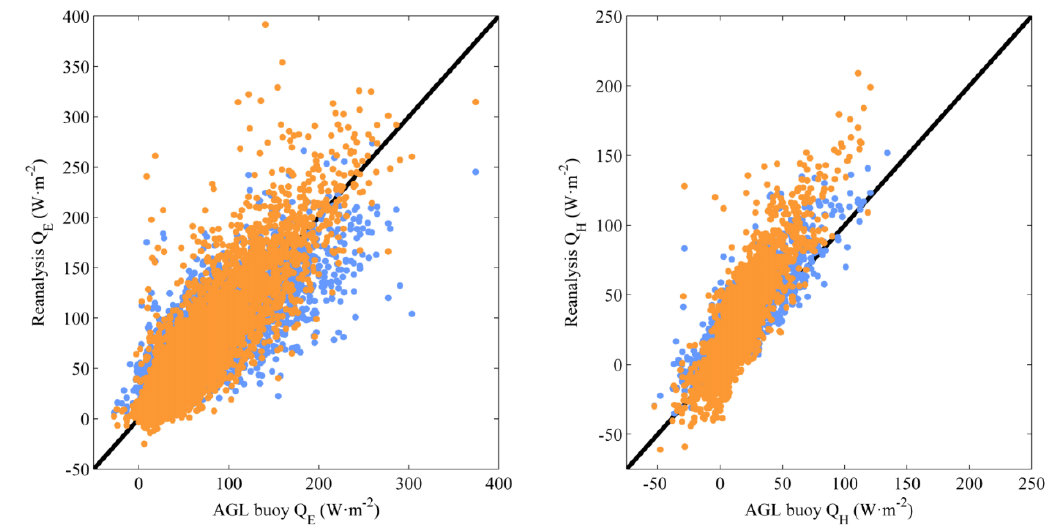
Figure 3. Comparison of latent (Q E ) and Sensible (Q H ) turbulent heat flux components estimated from AGL buoy data and obtained from NCEP / NCAR (orange dots) and OAFLUX (blue dots) reanalysis data sets.